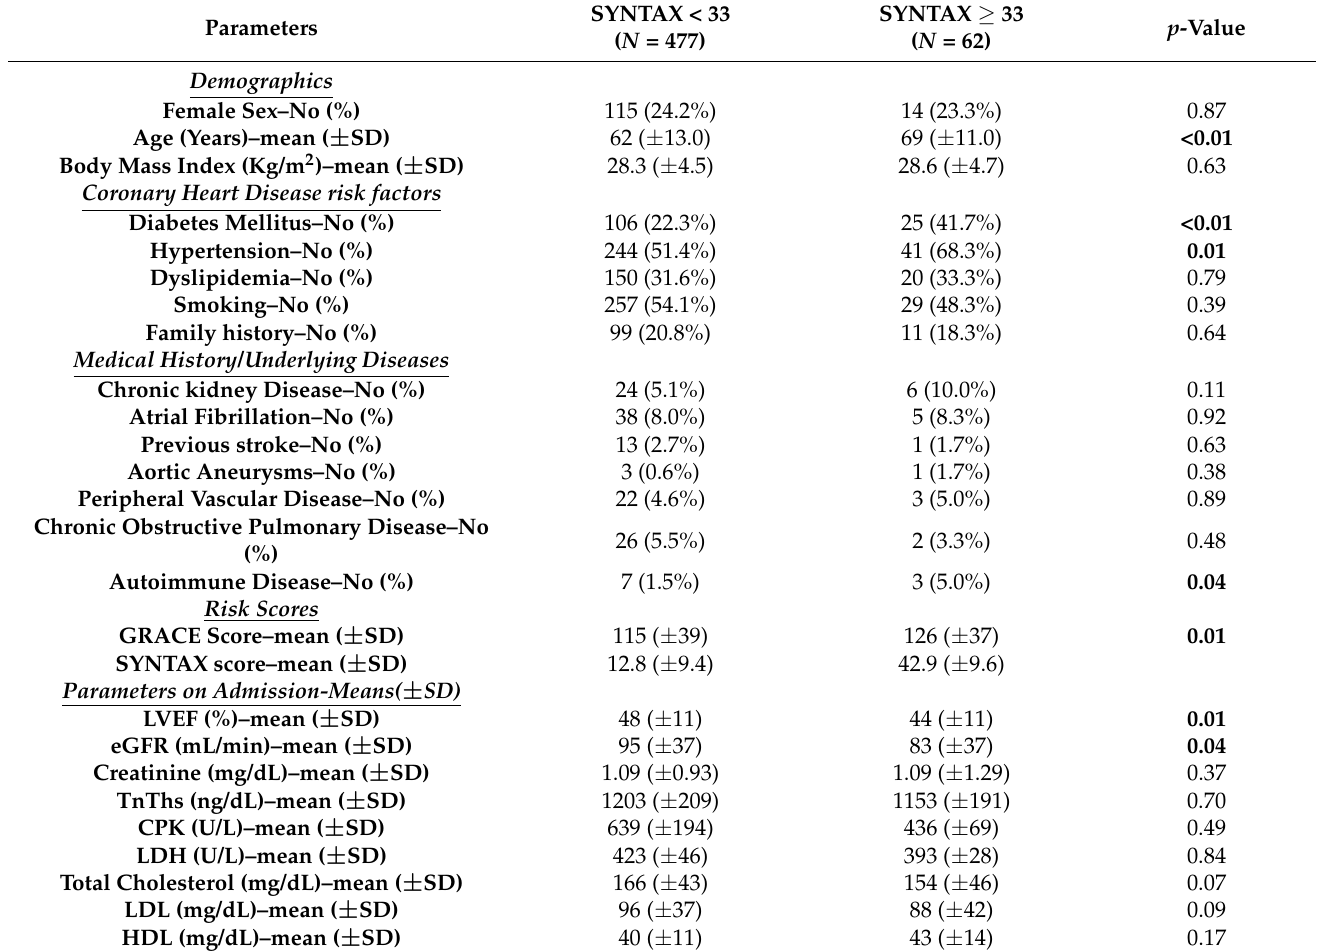
Table 1. Demographics and baseline clinical characteristics of study